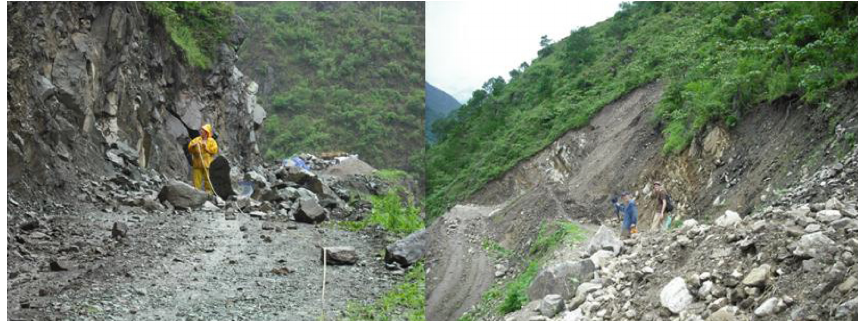
Figure 2. The highest landslide erosion occurred along a 1-year old road (DXD) leading to a remote village and a future hydropower plant just south of Daxingdi,